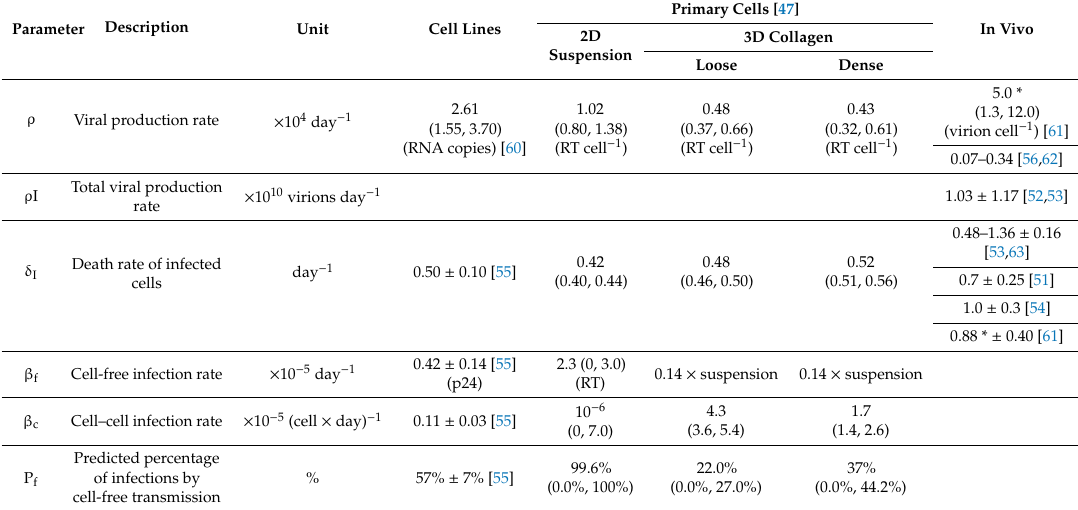
Table 1. Estimates for HIV-1 infection dynamics obtained from the analysis of experimental infection in cell lines or primary cells and in vivo patient data. Obtained estimates vary over several orders of magnitude due to di ff erent mathematical models and data types used. Please note that viral production rates vary in terms of units due to di ff erent quantification methods used. Numbers marked with (*) indicate estimates obtained for Simian Immunodeficiency Virus (SIV)